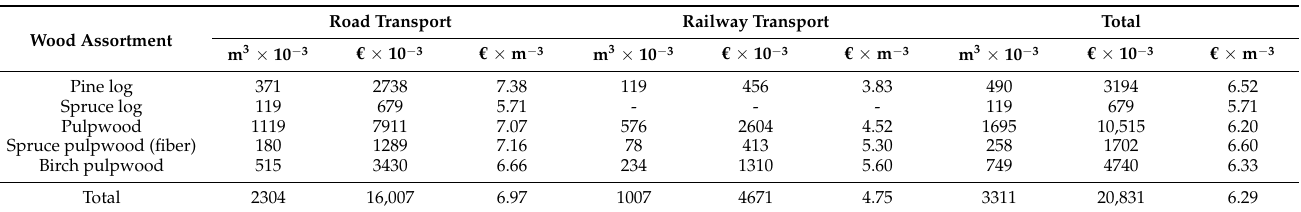
Table 2. Wood procurement area’s minimum long-distance transport amounts per wood assortment in the initial experiment in thousands of cubic meters, and transport costs in thousands of euros and as volume-weighted averages.